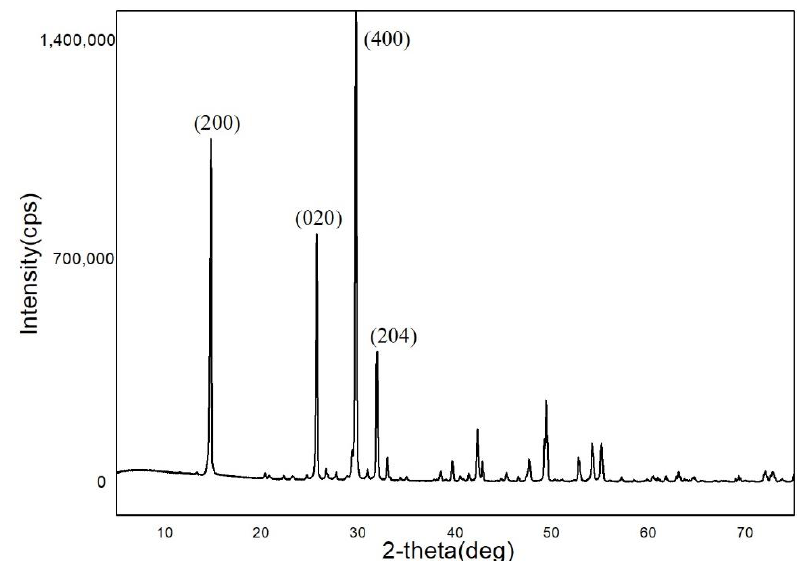
Figure 10. XRD pattern of the samples with columnar shape.